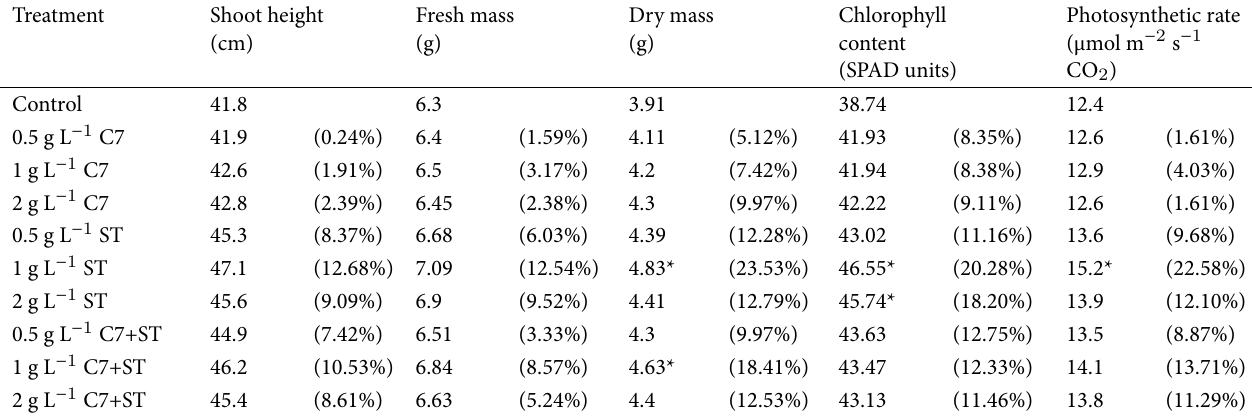
Table 2 Effect of foliar application of Celext 07 (C7) and Stimulagro (ST) as compared to control on soybean at thirtieth day after sowing.